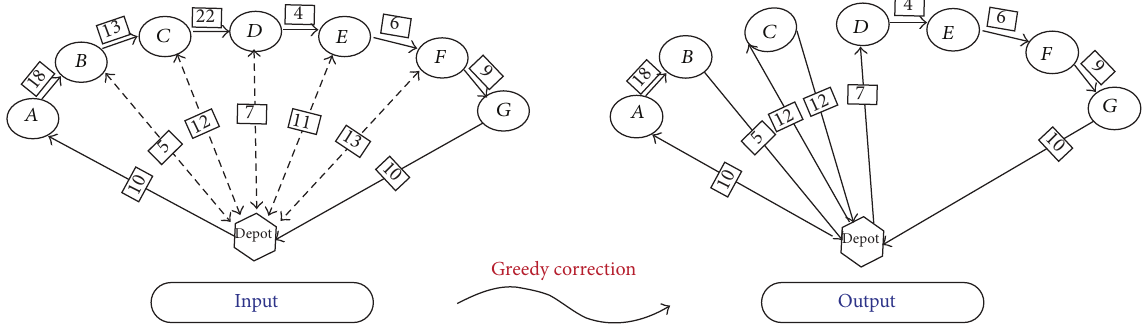
Figure 3: Illustration of greedy correction